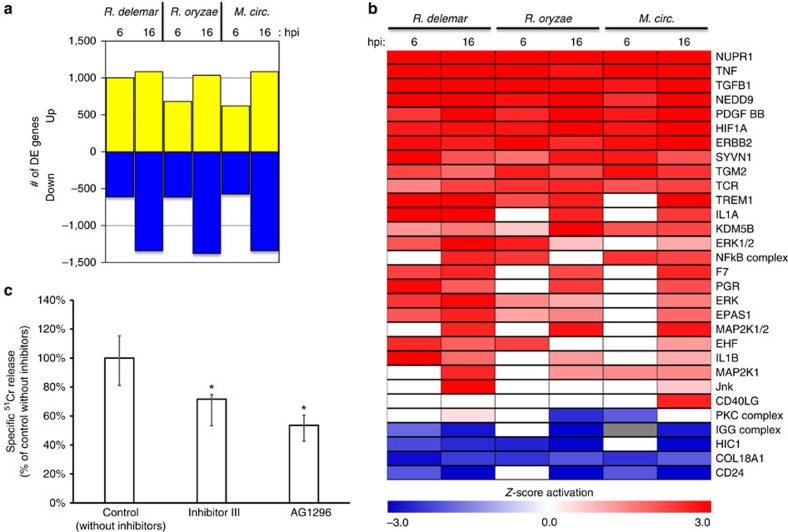
Host response to Mucorales fungi.(a) The number of host genes that were induced (yellow) or repressed (blue) by infection with each of the Mucorales fungi at 6 or 16 h after addition of fungal spores. (b) Host upstream regulators that are predicted to be modulated by Mucorales infection of airway epithelial cells based on expression of known downstream targets. Red indicates predicted activation (z score>2). Blue indicates predicted repression (z score<−2). White indicates no predicted regulation. (c) The effect of pharmacological inhibition of the PDFG receptor on R. delemar 99-880-induced cell damage of endothelial cells. Results are the median±interquartile range of two experiments, each performed in triplicate. *P<0.018 versus control; n=6.